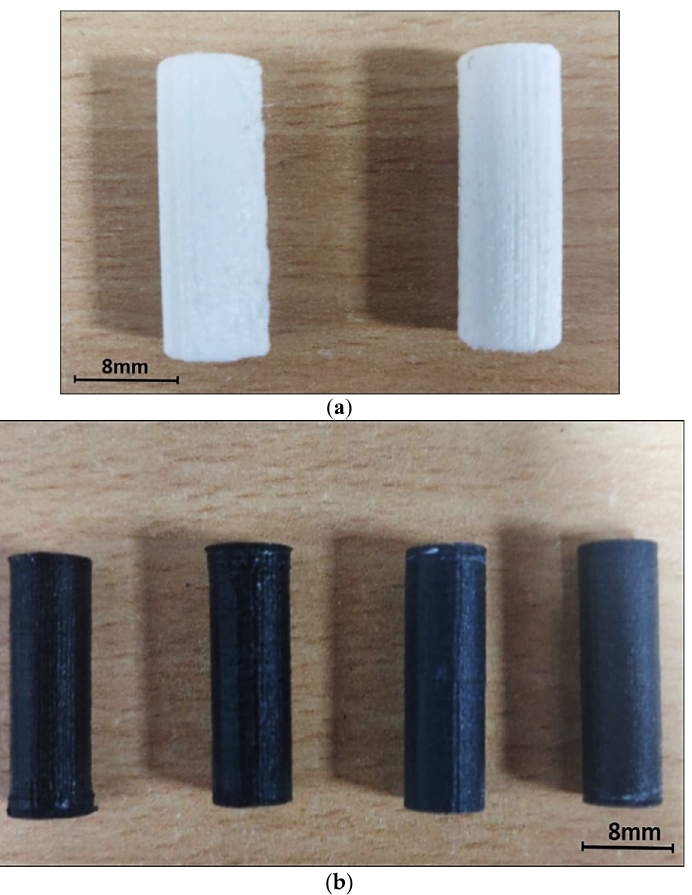
Figure 2. Schematic diagram of pin on disc machine (Tribometer) showing the details of specimen mounting and loading arrangements.